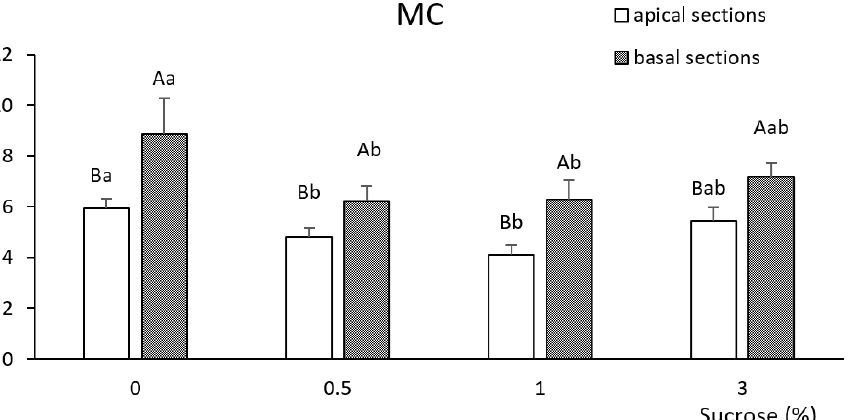
Figure 5. Effect of explant type and sucrose supplementation on multiplication coefficient of willow.